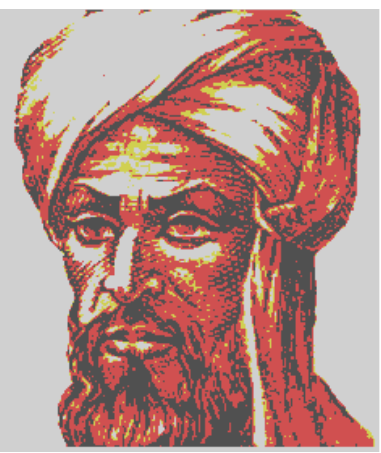
Figure 34. Khwarizmi using FCM.